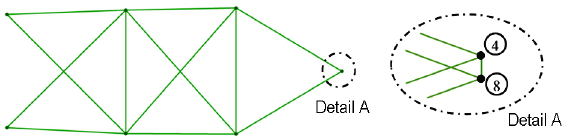
Fig. 3. Optimal layout for the planar 15-bar truss